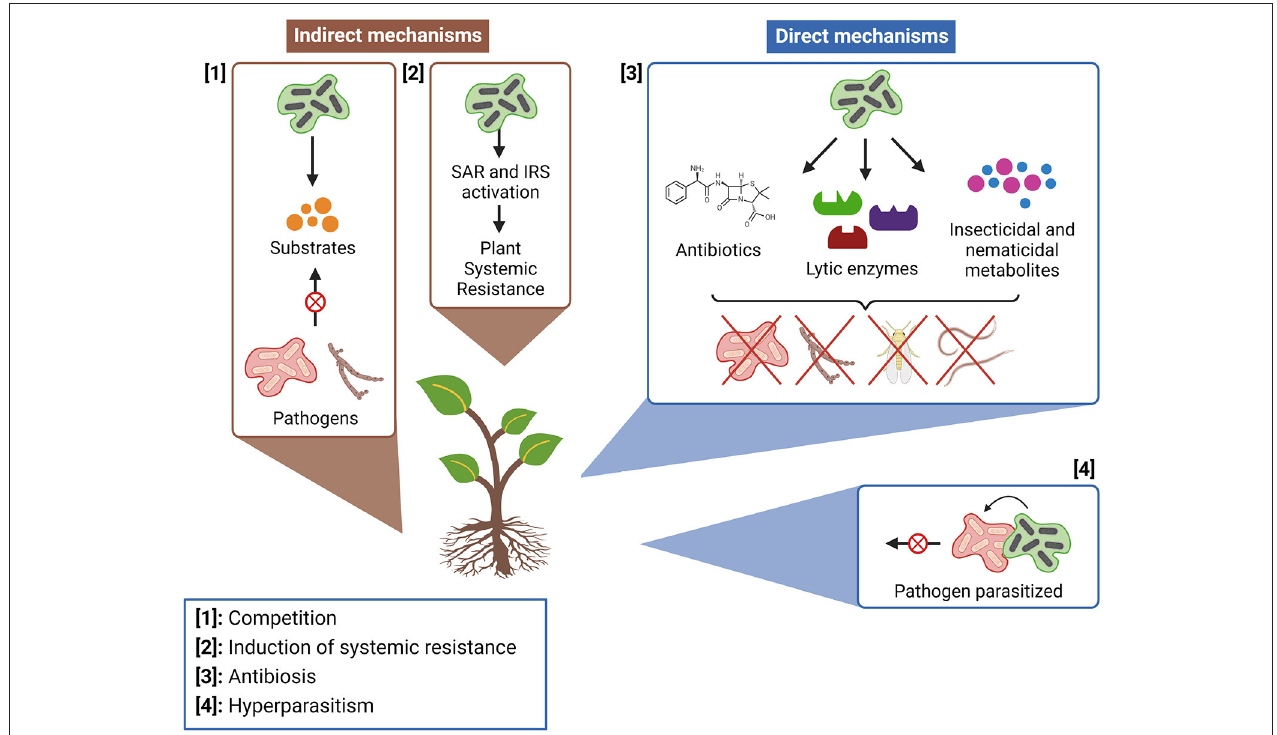
FIGURE 4 | Main mechanisms of action of microbial biocontrol agents (MBCAs; Figure by authors). Created with BioRender.com.